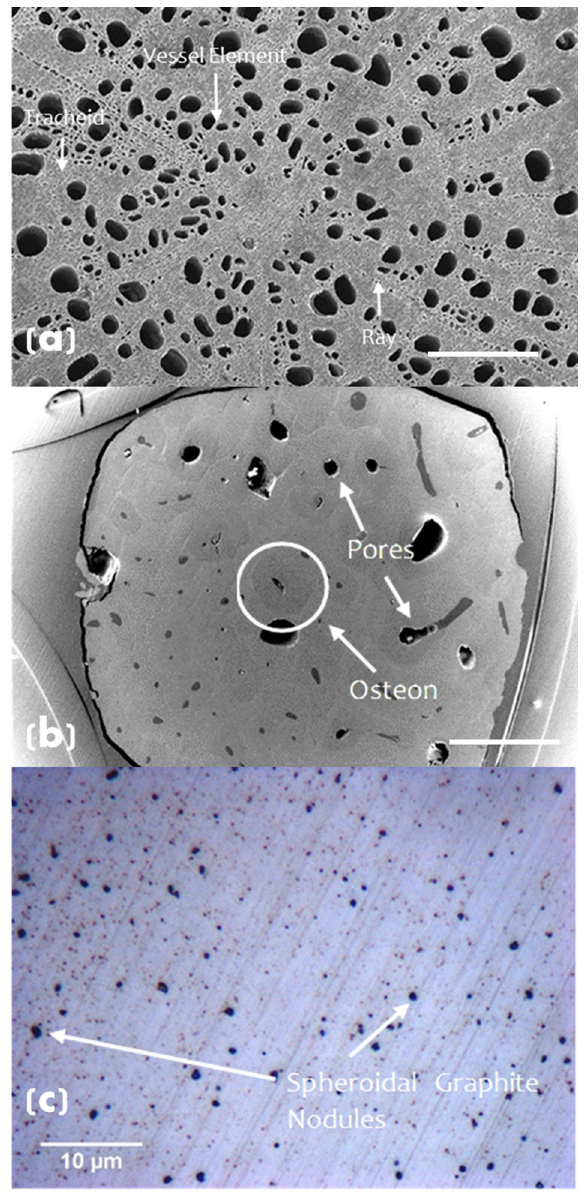
Figure 4. SEM micrograph from the cross section of ( a ) a root arrowhead (scale bar = 200 µm) and ( b ) a bone arrowhead (scale bar = 500 µm), ( c ) optical micrograph from the cross section of an iron arrowhead (scale bar = 10 µm).